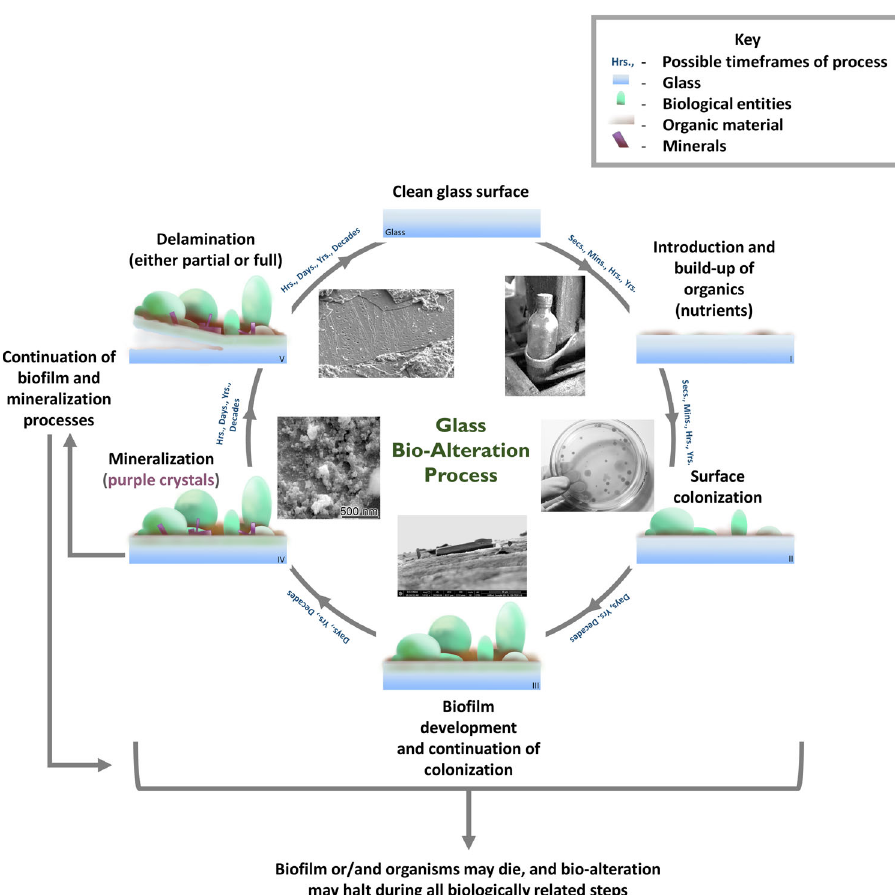
Fig. 2 Steps of bio-colonization of glass surfaces. Brown layer = organic material, green shapes = microorganism, green/brown layer = bio fi lm, purple shapes = minerals. Figure is not to scale and is only a graphical